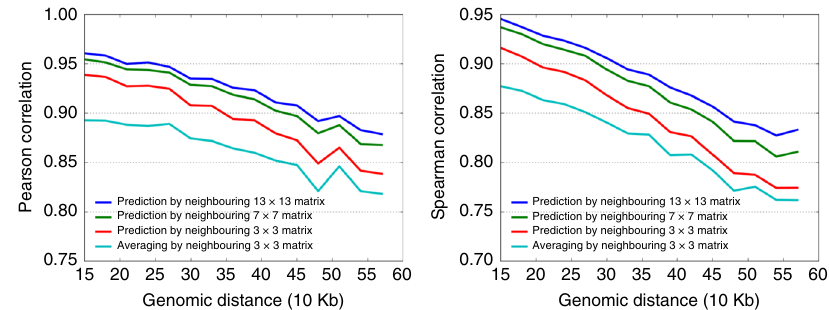
Fig. 2 Predicting chromatin interactions from their neighbouring regions. We trained a ConvNet model on chromosomes 1 – 17 and systematically predicted interaction matrices in chromosomes 18 – 22, using the 10 kb resolution Hi-C data in GM12878 cell line. We used three surrounding regions sizes (3 × 3, 7 × 7, 13 × 13) for prediction and also compared their performances with a naive prediction method that simply averages the neighbouring 3 × 3 matrix. We observe that using 13 × 13 matrix achieve the best performance at each genomic distance when evaluated by both Pearson and